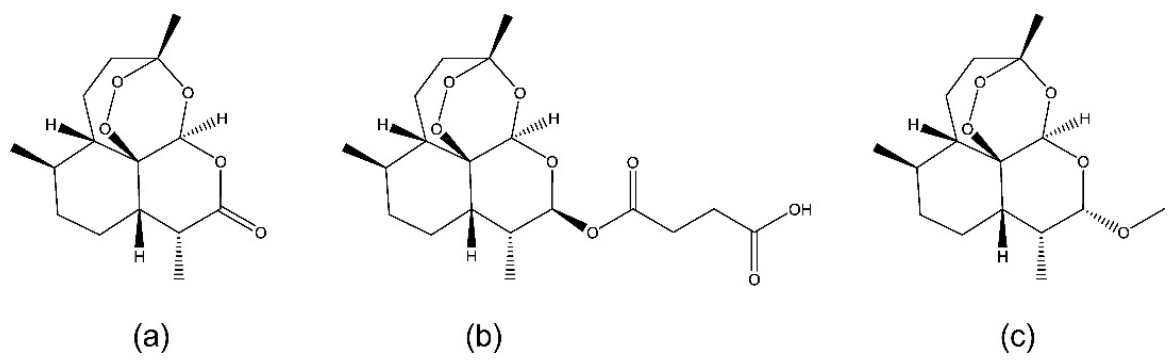
Figure 1. Chemical structures of artemisinin ( a ), artesunate ( b ) and artemether ( c ).